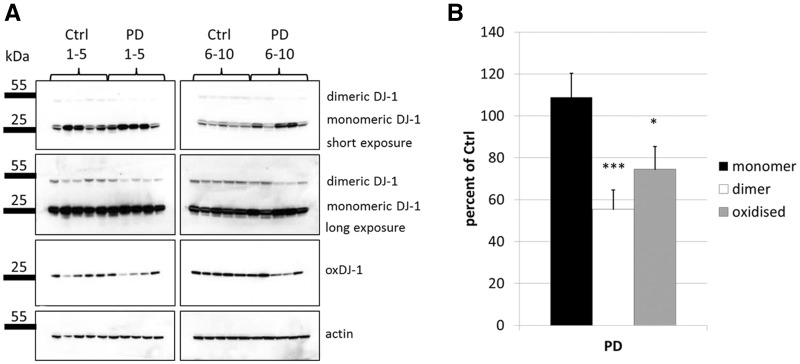
Levels of dimeric and oxidised DJ-1 are altered in human PD brain. (A) SDS PAGE and western blot analysis of human post mortem tissue lysates from 10 control individuals versus 10 PD patients. Membranes were probed for total DJ-1 (Enzo mouse monoclonal) to detect monomeric and dimeric forms of the protein. An antibody that detects oxidized DJ-1 at residue C106 (oxDJ-1) was also used. β-actin was used as a loading control. (B) Quantification of the western blots shown in (A). Statistical significance was calculated by one-way ANOVA with post hoc Tukey HSD test. *P < 0.05; ***P < 0.01 vs. control.